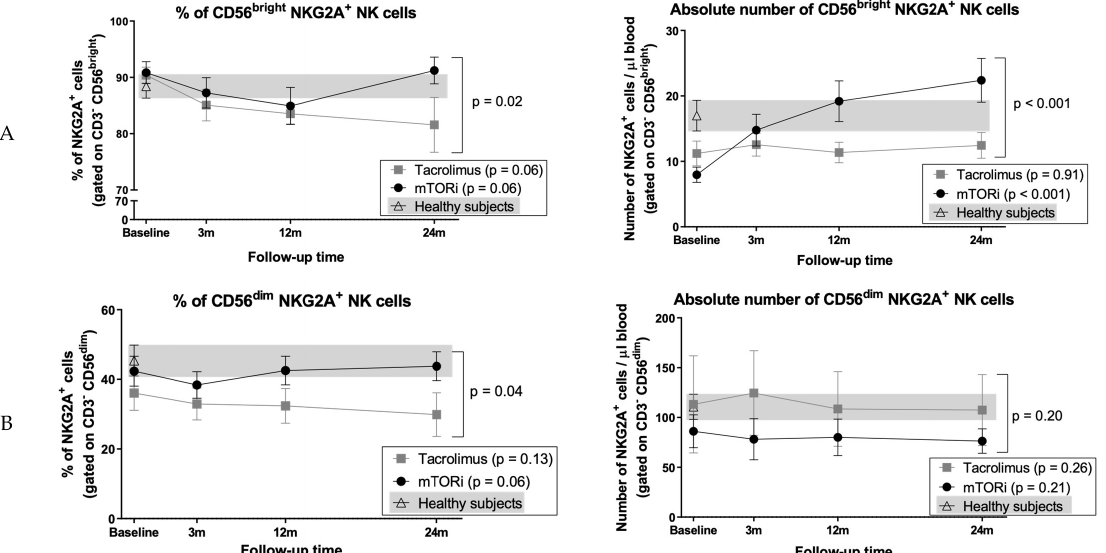
Figure 5. Evolution of CD94 / NKG2A expression in NK cell subsets. Analysis of NKG2A expression was carried out gating ( A ) CD56 bright and ( B ) CD56 dim NK cells. Patients before and after switching to mTORi are depicted with black dots, and patients maintaining tacrolimus are depicted with grey squares. HS data is depicted with white triangles, and the grey background corresponds to range. Plots show mean and SEM for each time point.